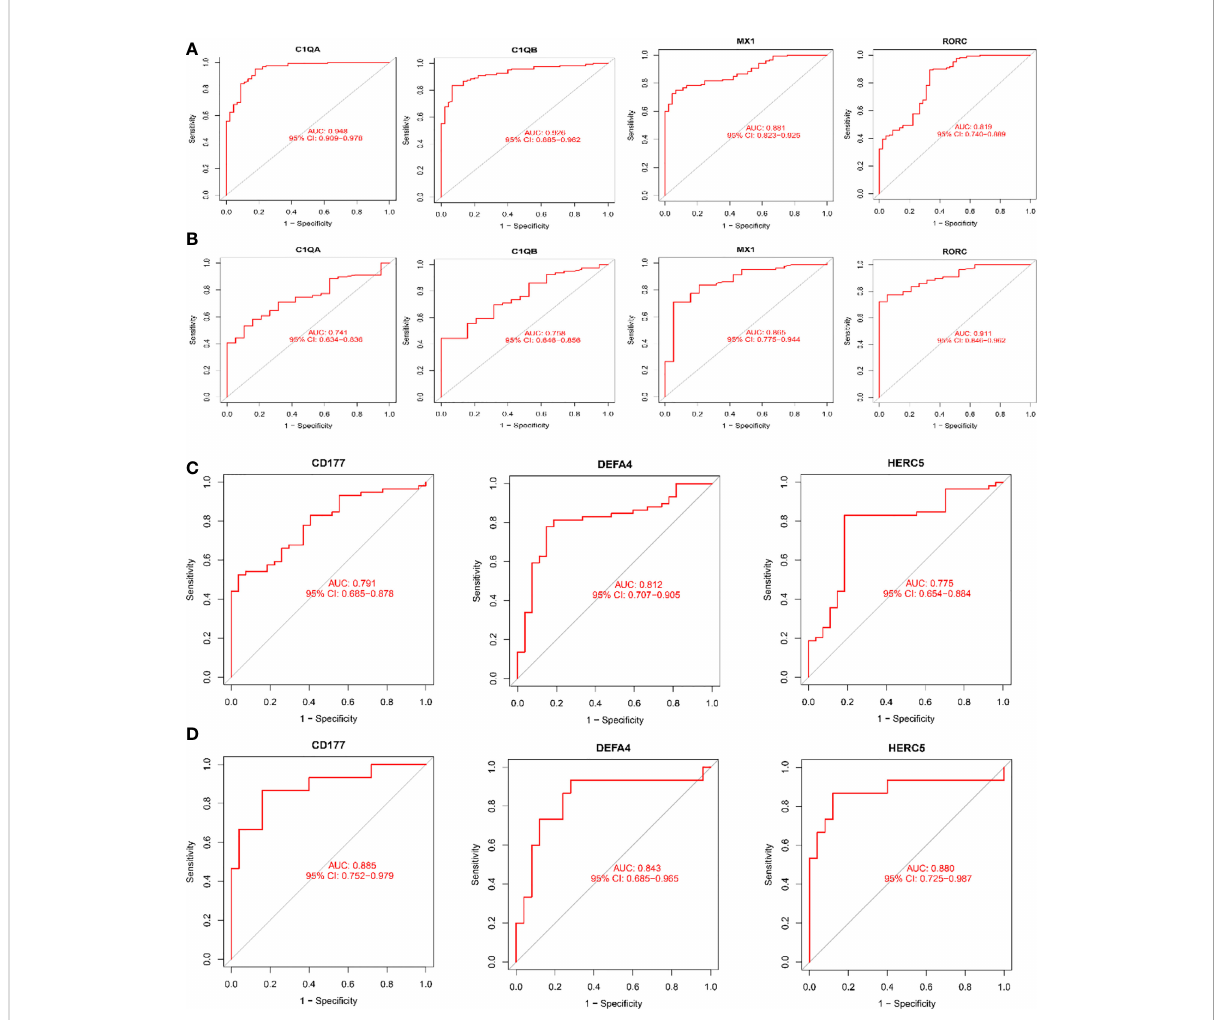
FIGURE 6 Receiver operating characteristic (ROC) curves for diagnostic validity of LN biodiagnostic markers. (A) ROC curves after fi tting one variable for C1QA, C1QB, MX1, and RORC in the original data cohort; (B) ROC curves after fi tting one variable for C1QB, MX1, and RORC in the GSE200306 data set. (C) ROC curve of CD177, DEFA4 and HERC5 after fi tting one variable in the original data cohort; (D) ROC curve of CD177, DEFA4 and HERC5 after fi tting one variable in the GSE81622 data set curve. (A, B) Kidney tissue; (C, D) Peripheral